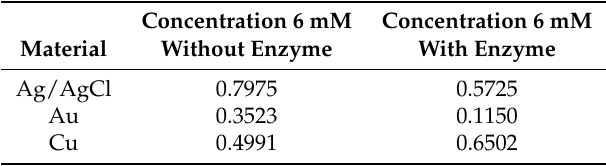
Table 5. Normality test— p -values for concentration of 6 mM.